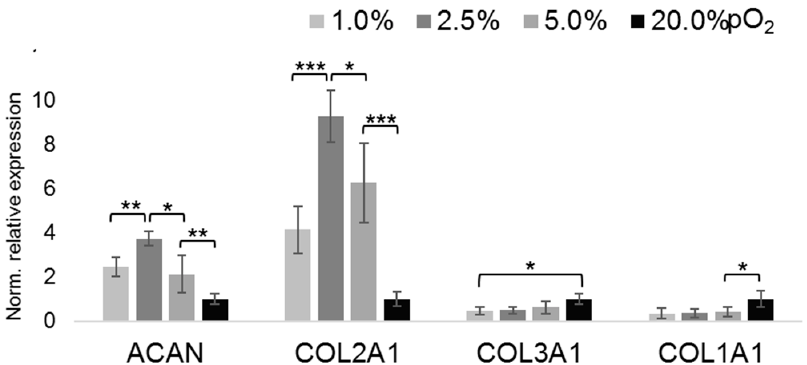
Figure 2. Oxygen tension-dependent expression of ECM markers. RT-qPCR gene expression analyses of aggrecan core protein ( ACAN ) and selected types of collagens as phenotypical markers to asses oxygenation level-dependent differentiation. Oxygenation levels (% pO 2 ) appear as grey scales, as shown within the figure. n = 6; * p < 0.05, ** p < 0.01, *** p <